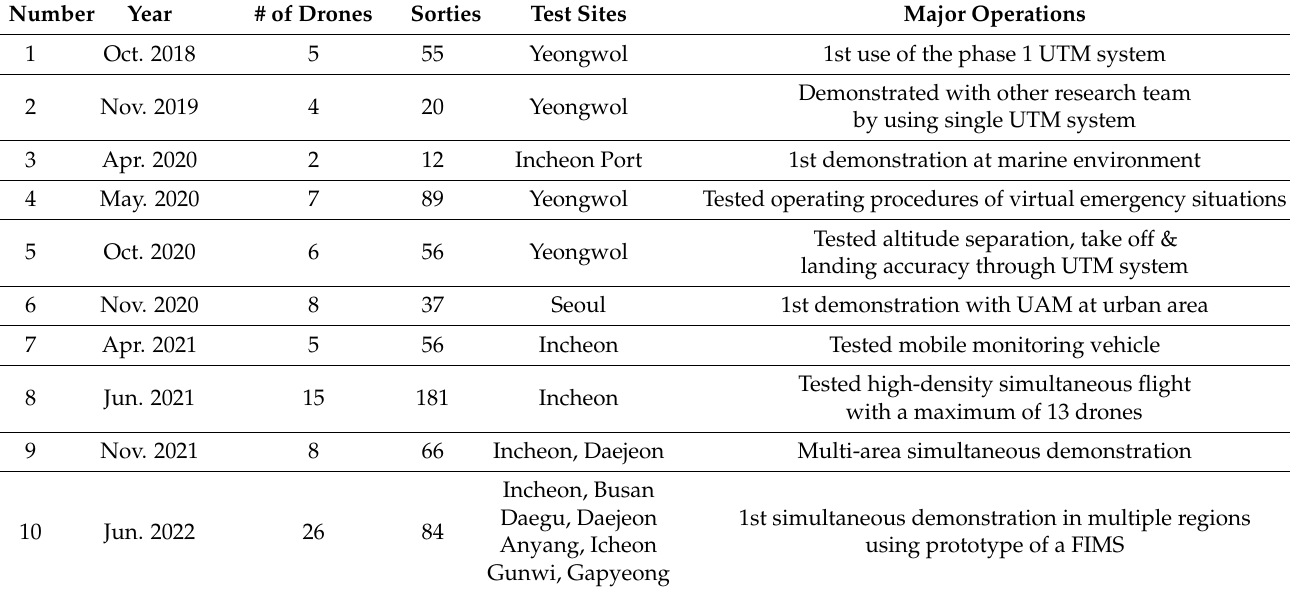
Table 1. Total of 10 flight demonstrations since 2018.